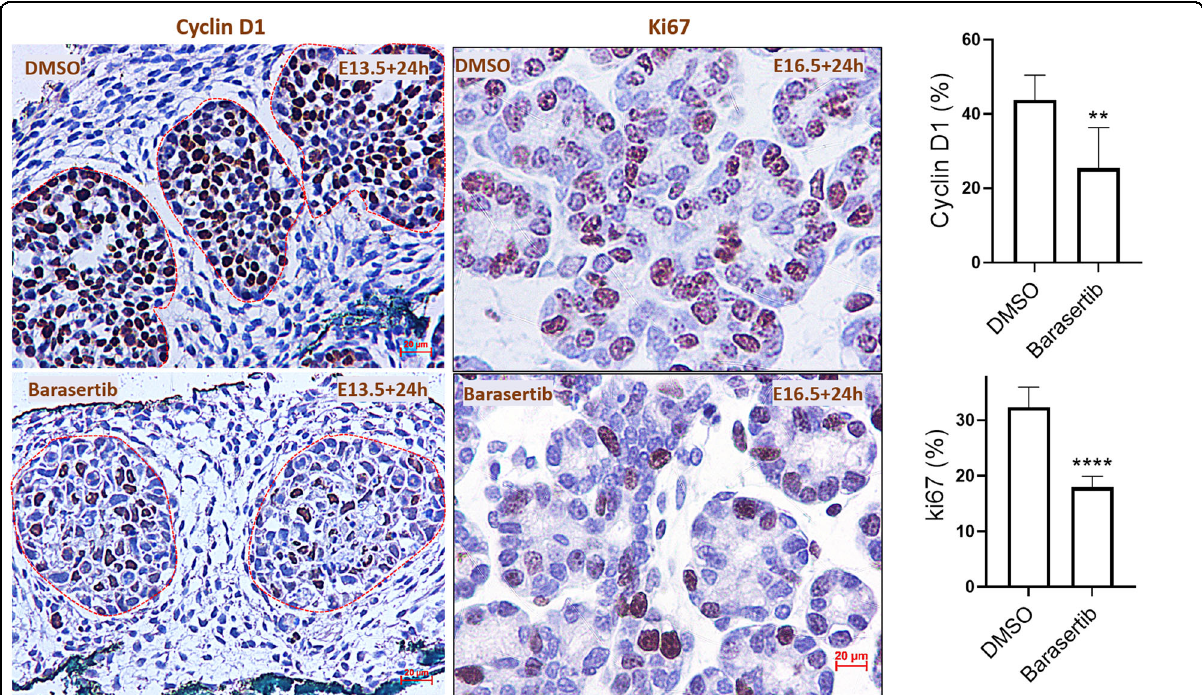
Fig. 5 AURKB regulates bud cell cycling and proliferation during salivary gland development. Cyclin D1 and ki67 immunoexpression (brown staining) at E13.5 + 24h and E16.5 + 24h, respectively. Extensive, nuclear immunolabelling of the epithelial buds in the DMSO-treated buds, with sparse expression of both markers in the explants treated with Barasertib. Counting the percentage of immunopositive nuclei revealed nearly 50% loss in number of cycling (Cyclin D1) and proliferating cells (ki67), analysed by paired Student ’ s t test (** P ≤ 0.01, **** P ≤ 0.0001), scale bar = 20